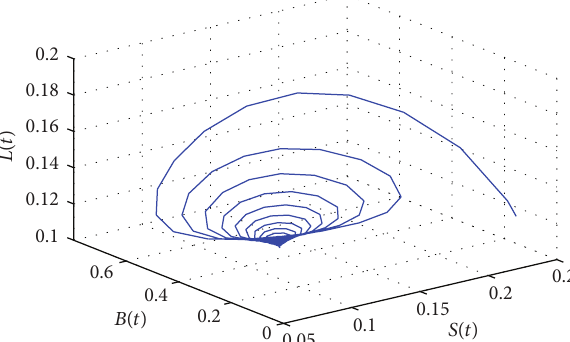
Figure 1: The phase plot of states 𝑆 , 𝐿 , and 𝐵 for 𝜏 = 55.2386 < 𝜏 0 = 58.5472 .